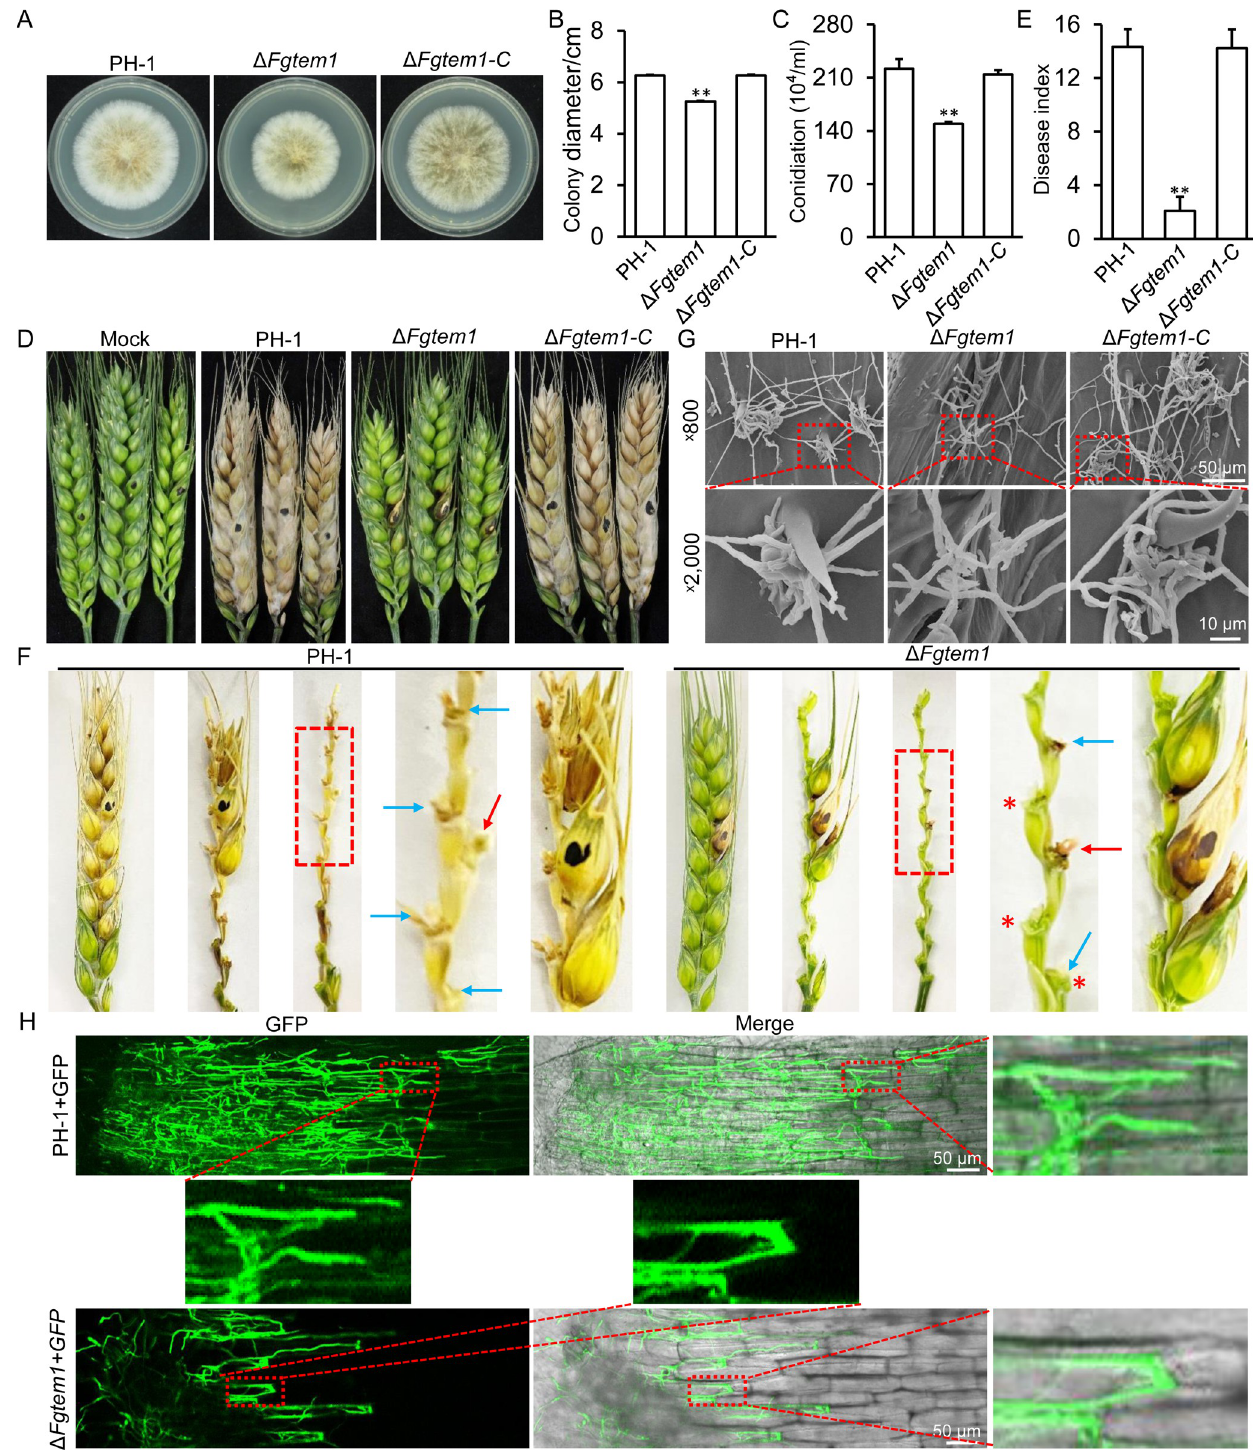
Fig 1. FgTem1 is critically required for the pathogenicity of F. graminearum . (A-B) shows the colonies and colony diameters of the wild type PH-1, FgTEM1 deletion mutant ( Δ Fgtem1 ) and complemented strain ( Δ Fgtem1 -C) on complete medium (CM) agar plates after 3 days of incubation. Two-tailed Student t -test was used for paired comparison of the colony diameter between Δ Fgtem1 and PH-1. ( �� P < 0.01). (C) Conidiation of PH-1, Δ Fgtem1 and Δ Fgtem1 -C in CMC media after 3 days. Two-tailed Student t -test was used for paired comparison of the conidiation between Δ Fgtem1 and PH-1. ( �� P < 0.01). (D) Pathogenicity of PH-1, Δ Fgtem1 and Δ Fgtem1 -C in wheat heads. The infected wheat heads were examined at 14 days after inoculation. (E)